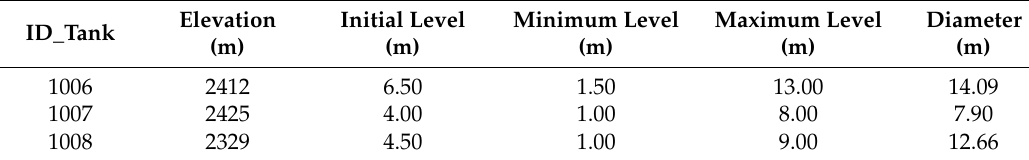
Table 5. New tanks added to the FRM network.